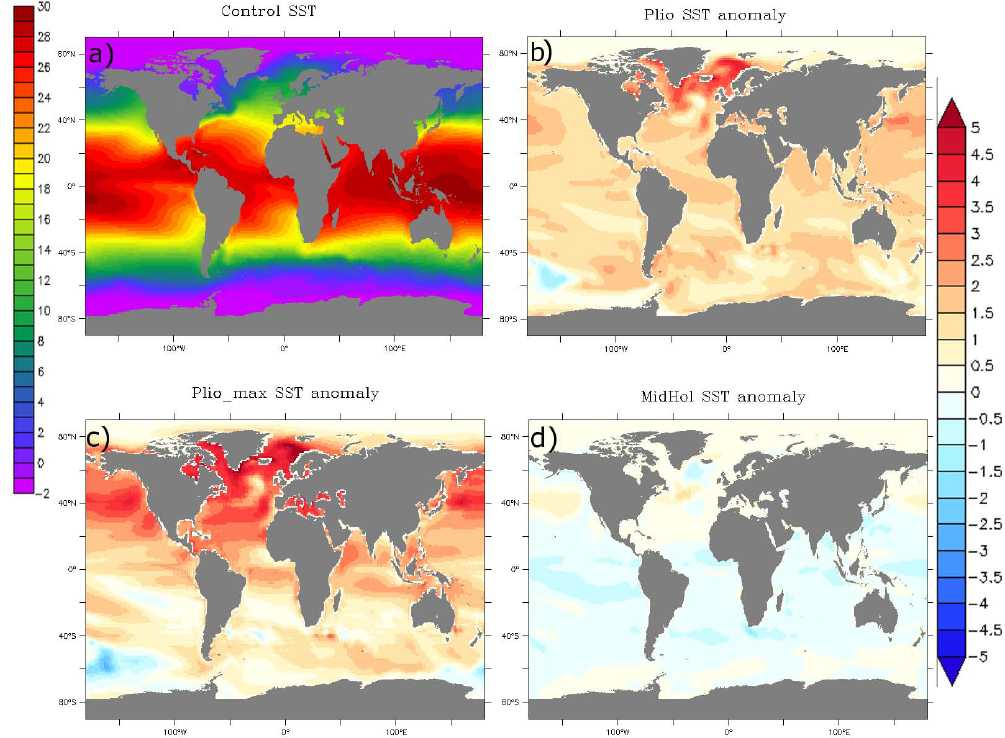
Fig. 2. SSTs imposed in LMDZ4 for (a) control (b) Plio, (c) Plio max and (d) MidHol experiments, (b-d) expressed as difference from the control SSTs (1988–2007 mean), in ◦